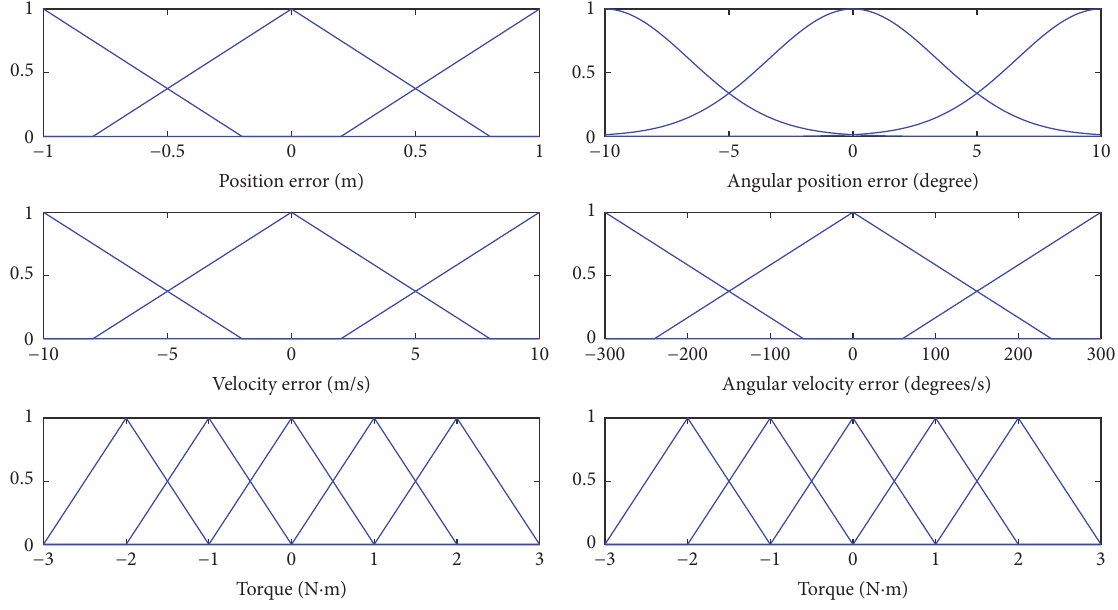
Figure 7: Fuzzy sets of the third